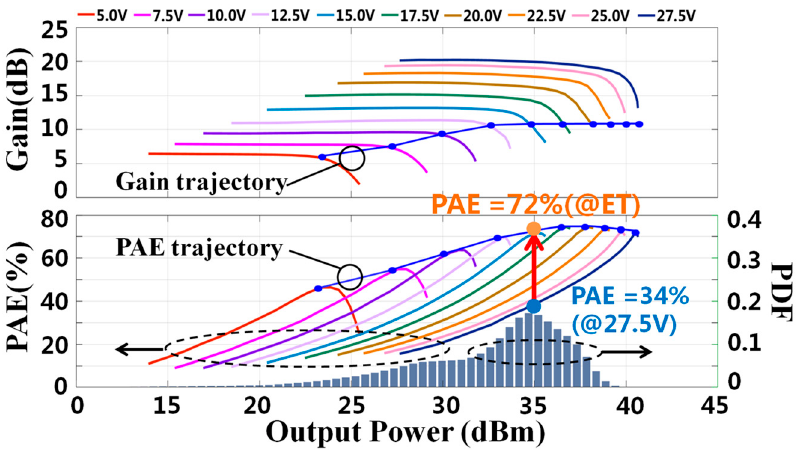
Figure 7. Measured results of the fabricated PA at various drain biases (from 5 V to 27.5 V with 2.5 V step). Table 2. Summary and comparison of the RF PA performances (under low supply voltage condition) used in envelope tracking (ET) architecture.